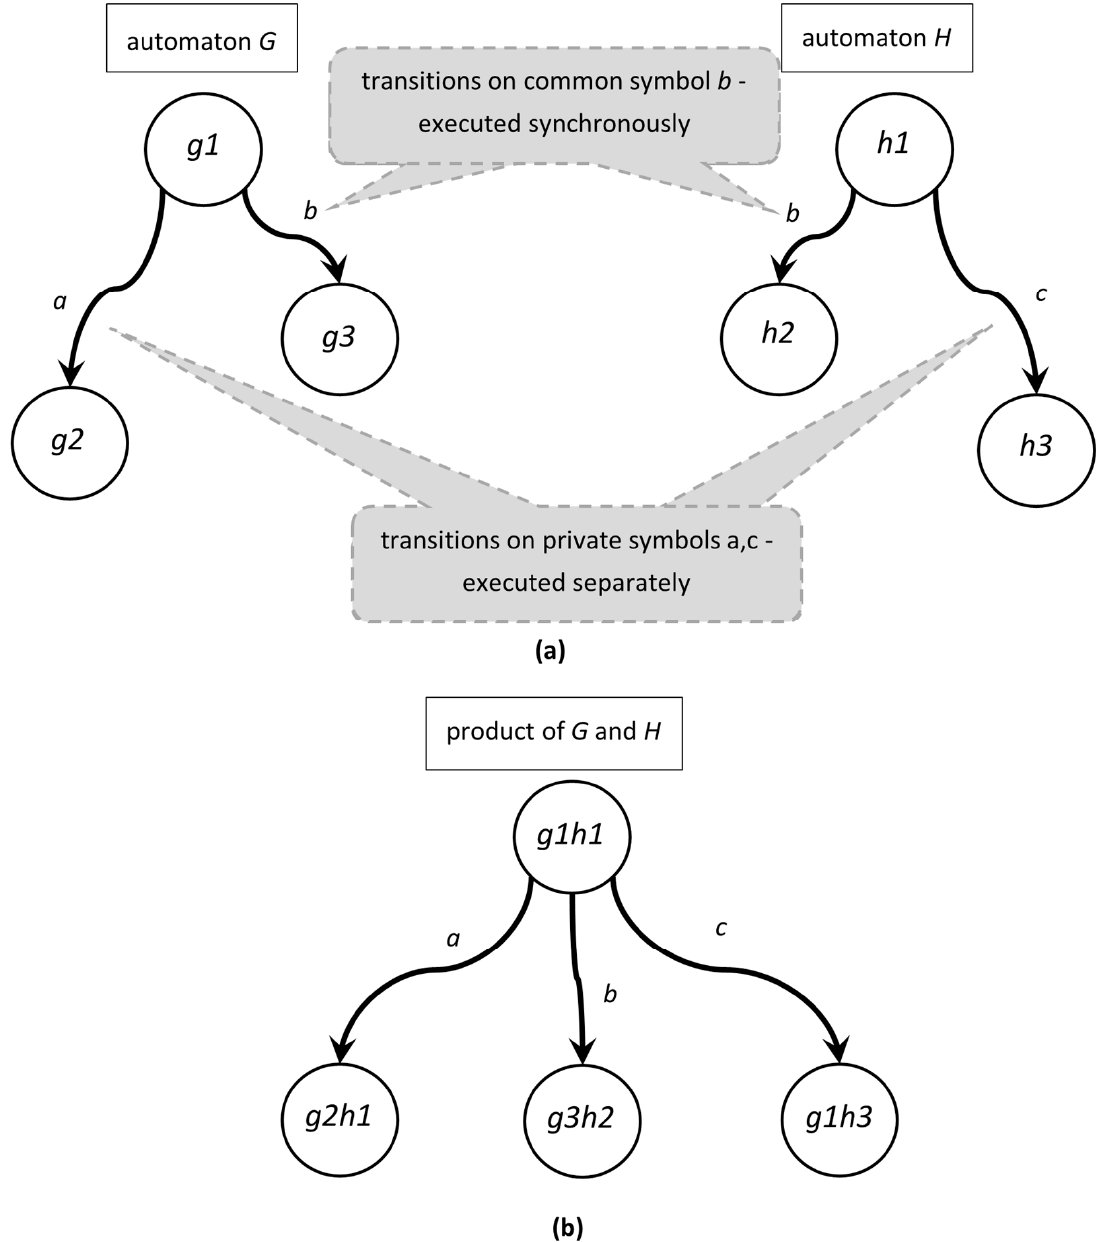
Figure 2. Automata in synchronous models: ( a ) two automata G and H with independent internal actions a and c and one common synchronous action, b; ( b ) the product of automata G and H.